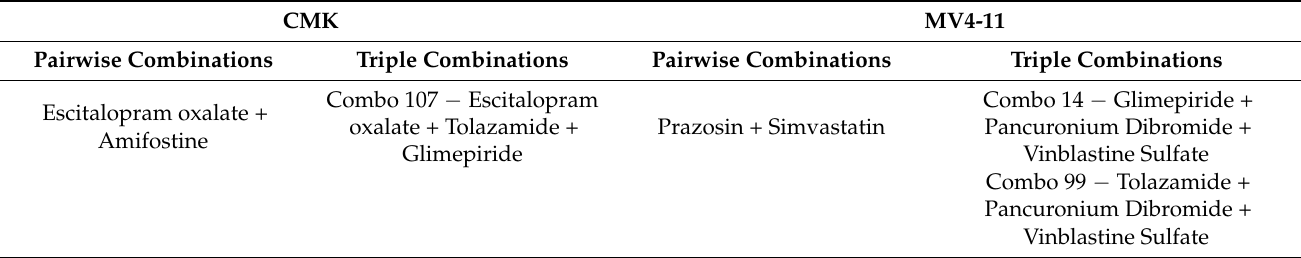
Table 1. Pairwise and triple combinations that demonstrated a Z-score > 2 in the CMK and MV4-11 cell